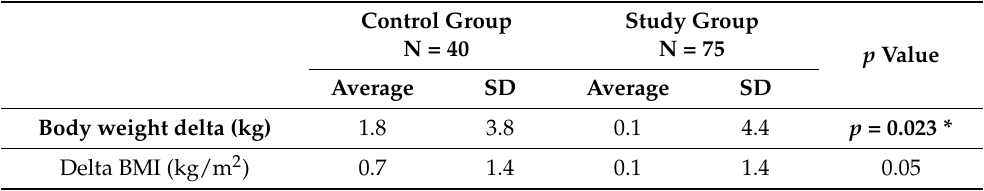
Table 8. Changes in body weight and BMI values before and after chemotherapy in the control and study groups.